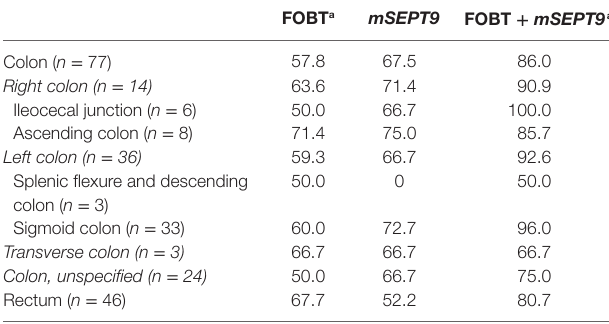
Table 4 presents further stratifications by tumor location. mSEPT9 had higher sensitivity for colon cancer compared